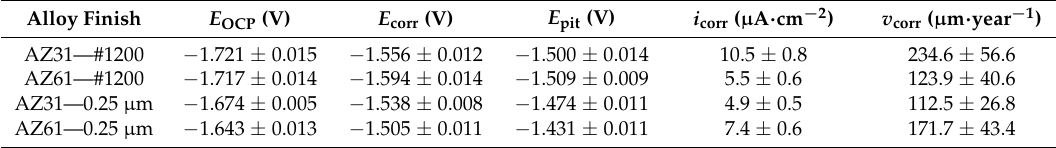
Table 4. Results of potentiodynamic tests performed in enriched HBSS+ (with Mg 2+ and Ca 2+ ions).